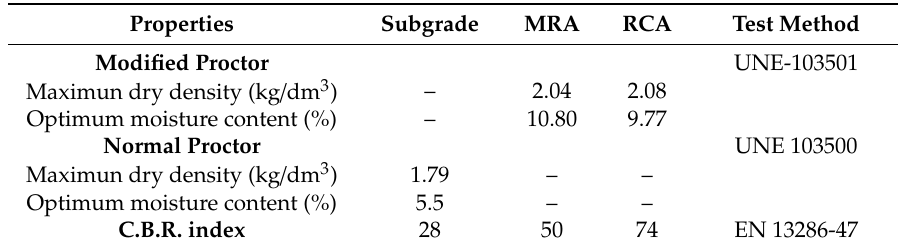
Table 4. Results of experimental tests performed in the